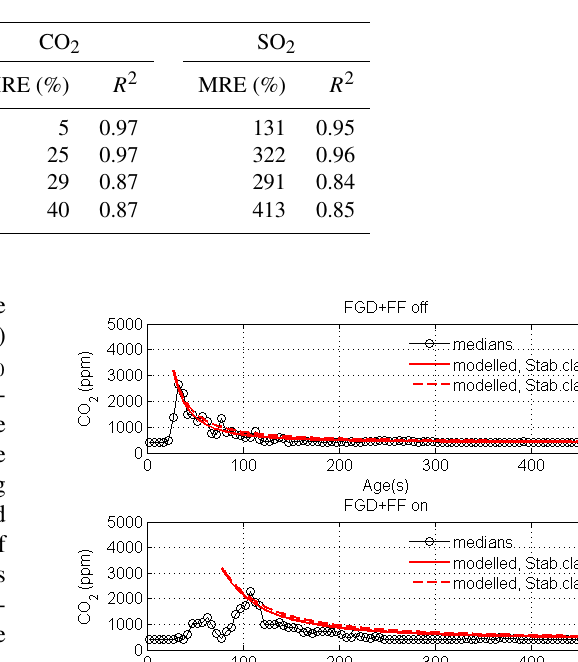
Table 2. Comparison between modelled CO 2 concentration and measured CO 2 concentration, and comparison between SO 2 measured from the atmosphere and Gaussian-model-diluted SO 2 . Mean relative error (MRE) and correlation coefficients ( R 2 ) were calculated between measured and modelled concentrations.